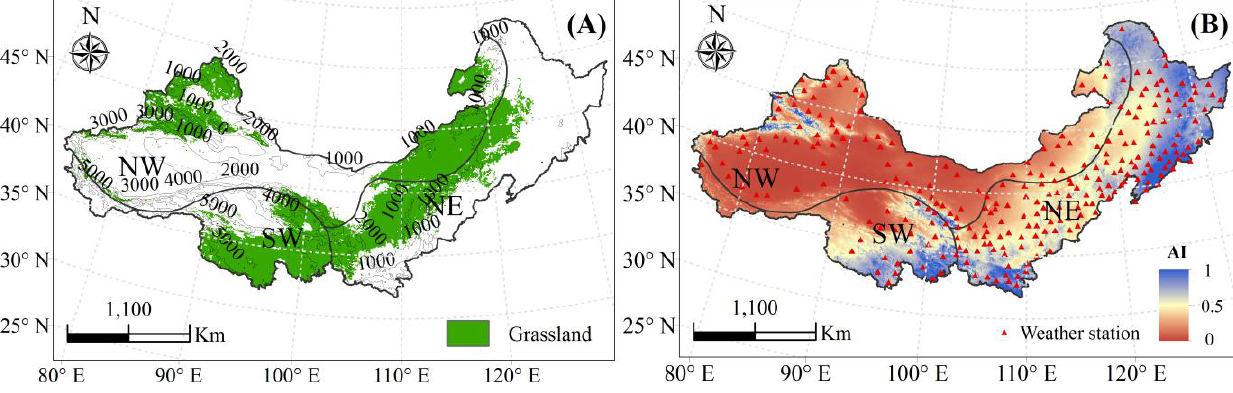
Figure 1. Distribution of grasslands ( A ) and aridity index (AI) ( B ) in northern China. The green color area represents grasslands extracted from the MODIS global land cover dataset in 2005 and the gray lines represent elevation contour. The red color triangles indicate weather stations. The study area was divided into three climate zones, the northeastern part (NE), influenced by temperate monsoon climate, the northwest part (NW), influenced by temperate continental climate and the southwest part (SW), influenced by alpine